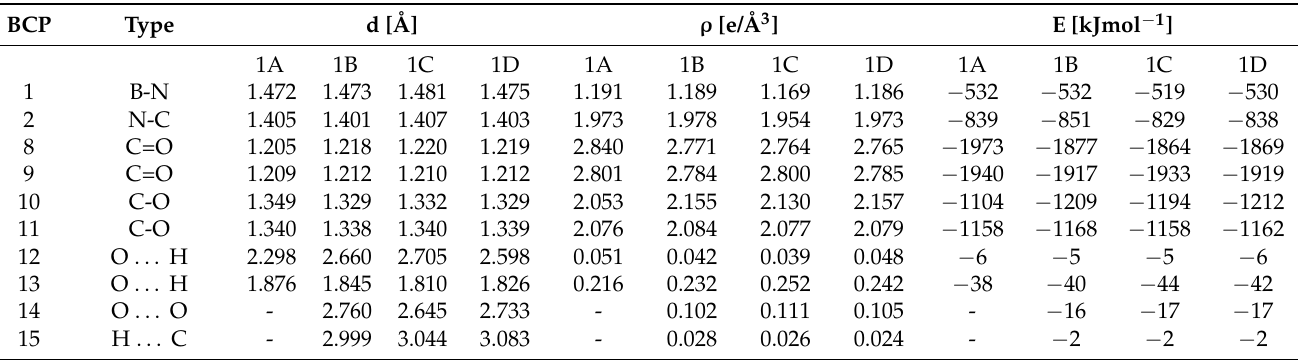
Table 4. Properties of the electron density at the selected bond critical points (BCPs, see Figure 4) of the four lowest energy conformations of compound 1. The parameters are d = bond distance, ρ = electron density, E = total energy at the